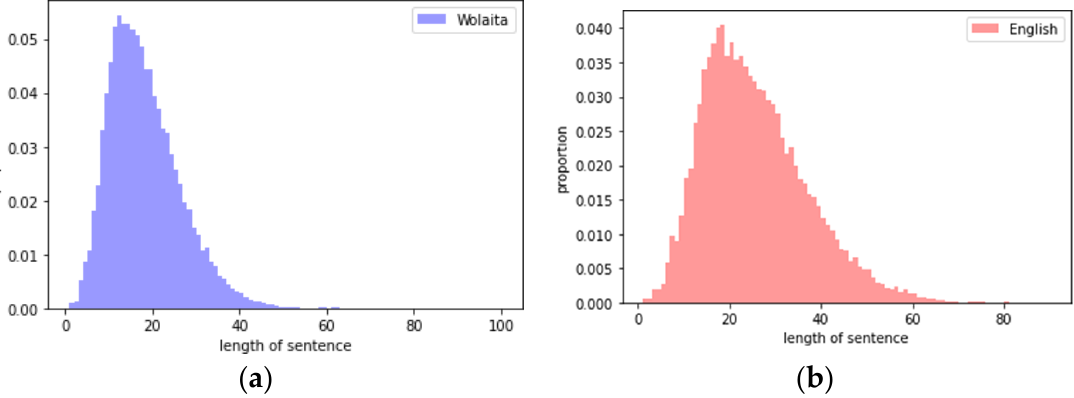
Figure 3. Sentence word count in ( a ) Wolaytta and ( b ) English parallel datasets. As can be observed in ( a , b ), the word count per sentence in Wolaytta and English is within the range [2–40].